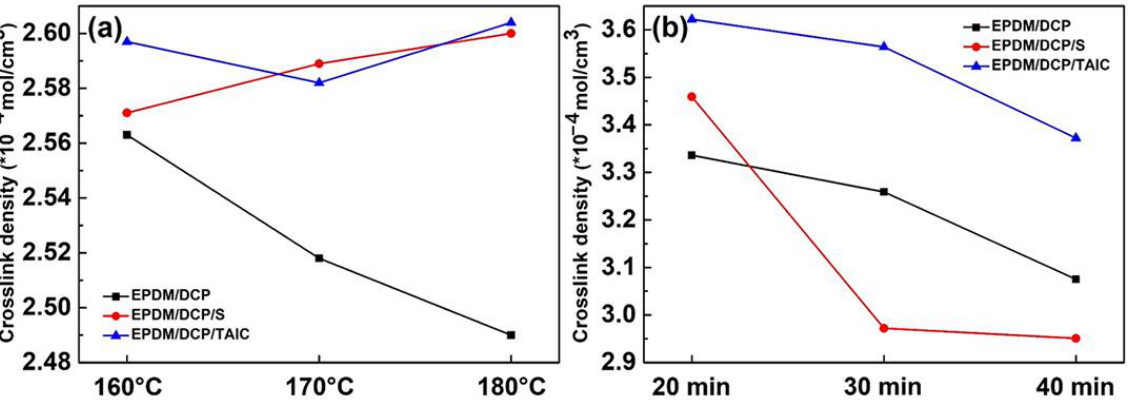
Figure 2. The crosslink density of EPDM rubbers ( a ) 1 h at various temperatures (160 °C, 170 °C, 180 °C); ( b ) 160 °C for various times (20 min, 30 min, 40 min).